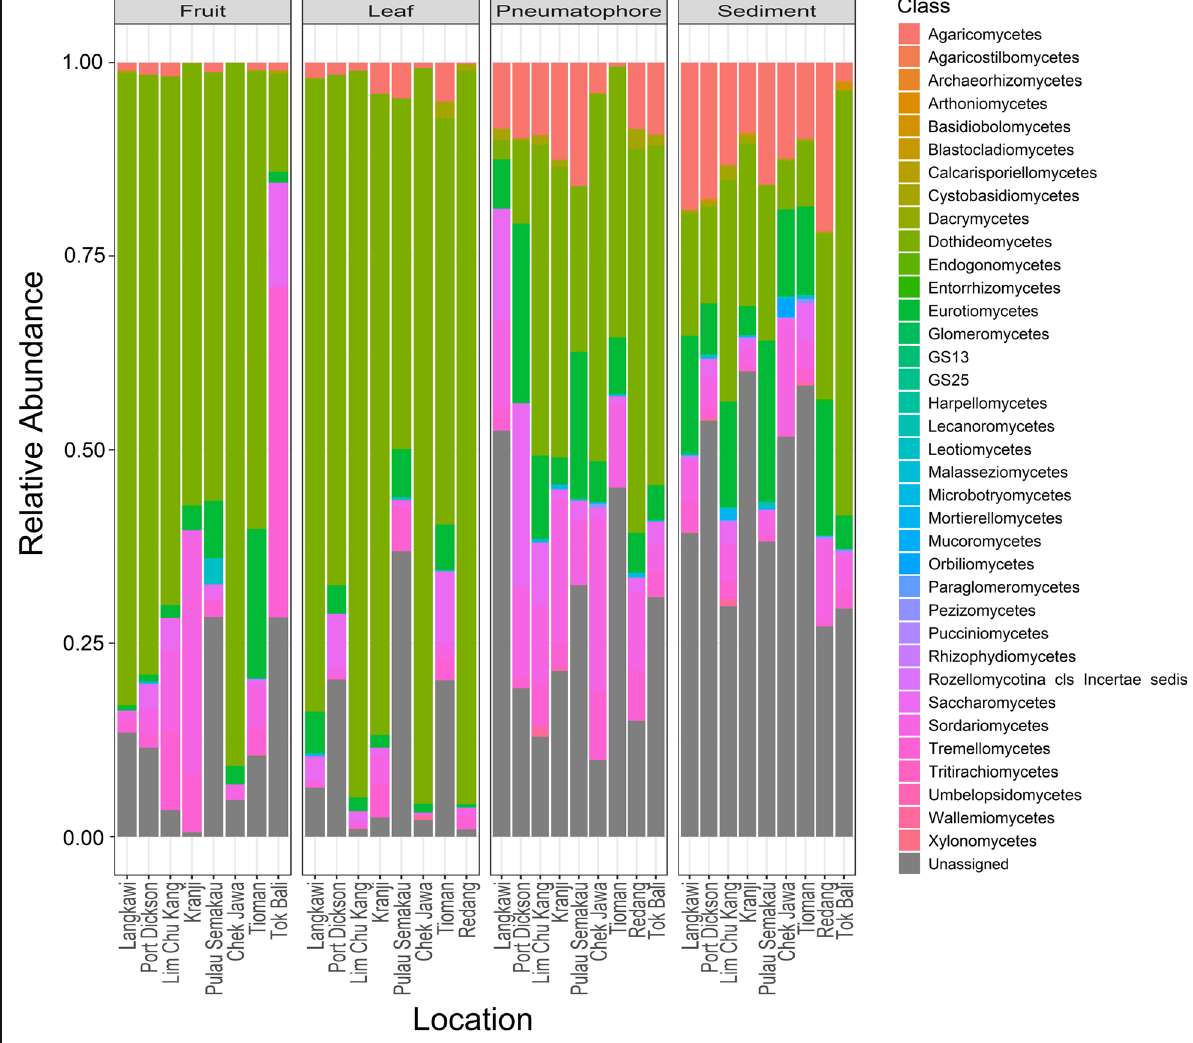
Fig. 3 Stacked bar plots of relative class abundances in each part from each sample